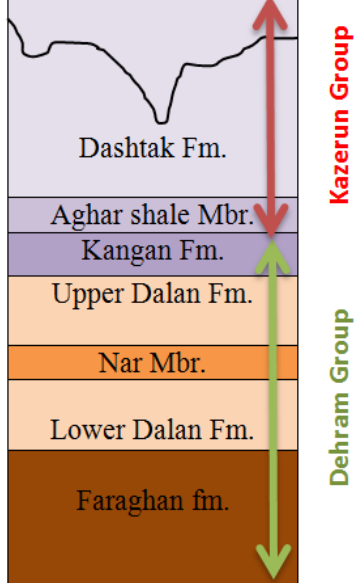
Figure 5. Chronological chart of Fars domain